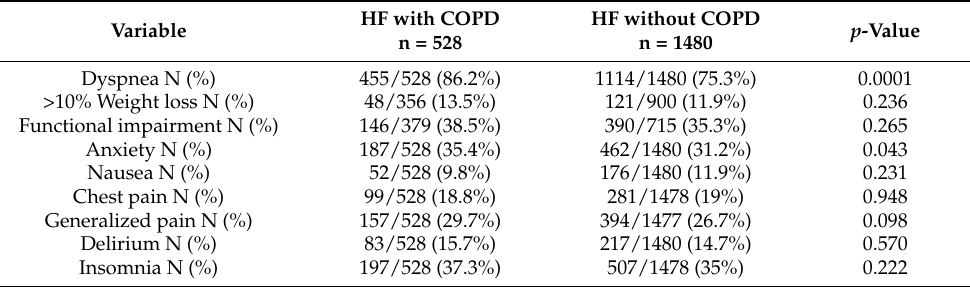
Table 2. Clinical manifestations of advanced disease evaluated among elderly acute HF patients with and without